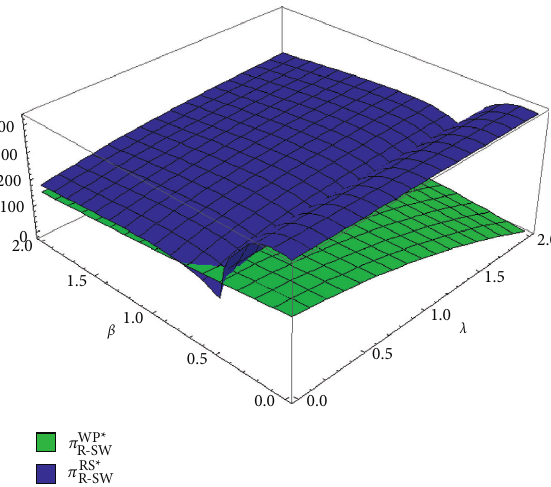
Figure 10: Effect of λ and β on effort.